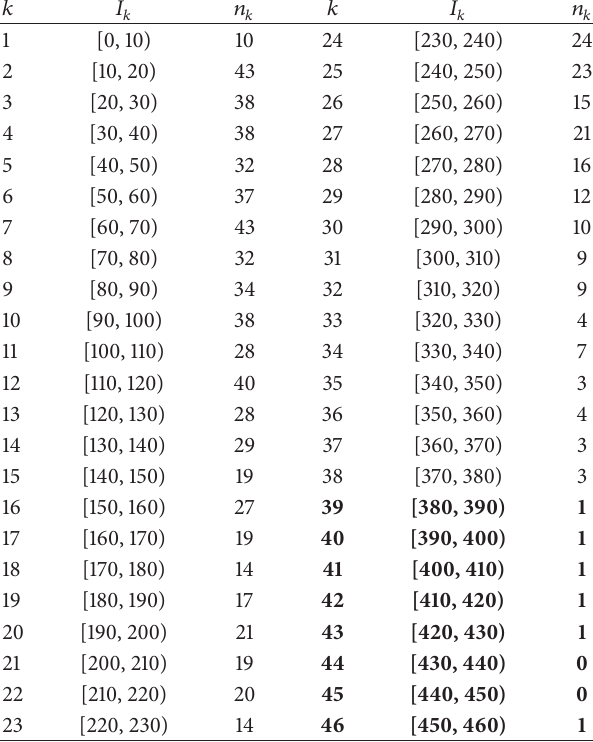
Table 6: Numbers 𝑛 𝑘 of whole leaves classified in groups 𝐺 𝑘 (𝑙) formed by leaf sizes varying in corresponding length intervals 𝐼 𝑘 .